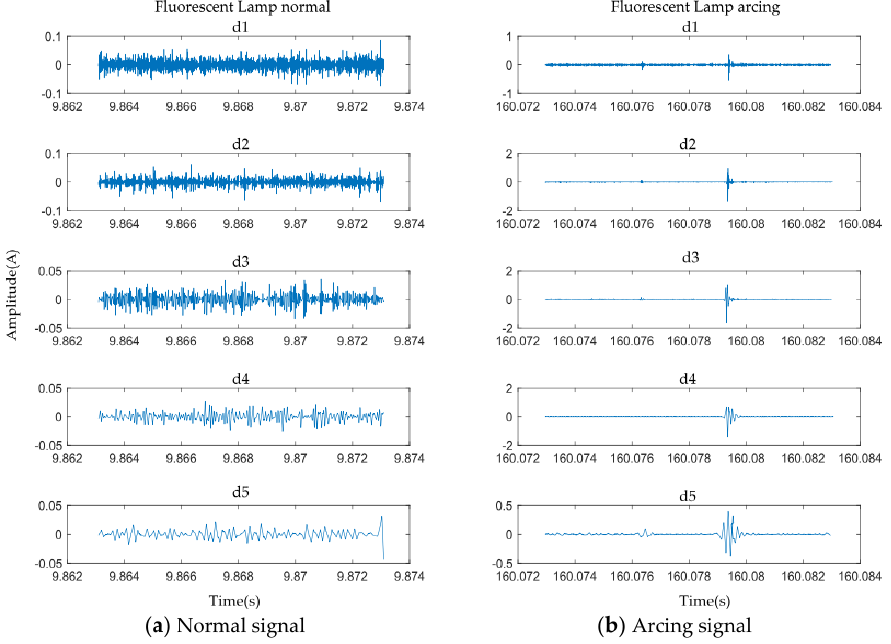
Figure 9. Wavelet decomposition comparison of a fluorescent lamp.